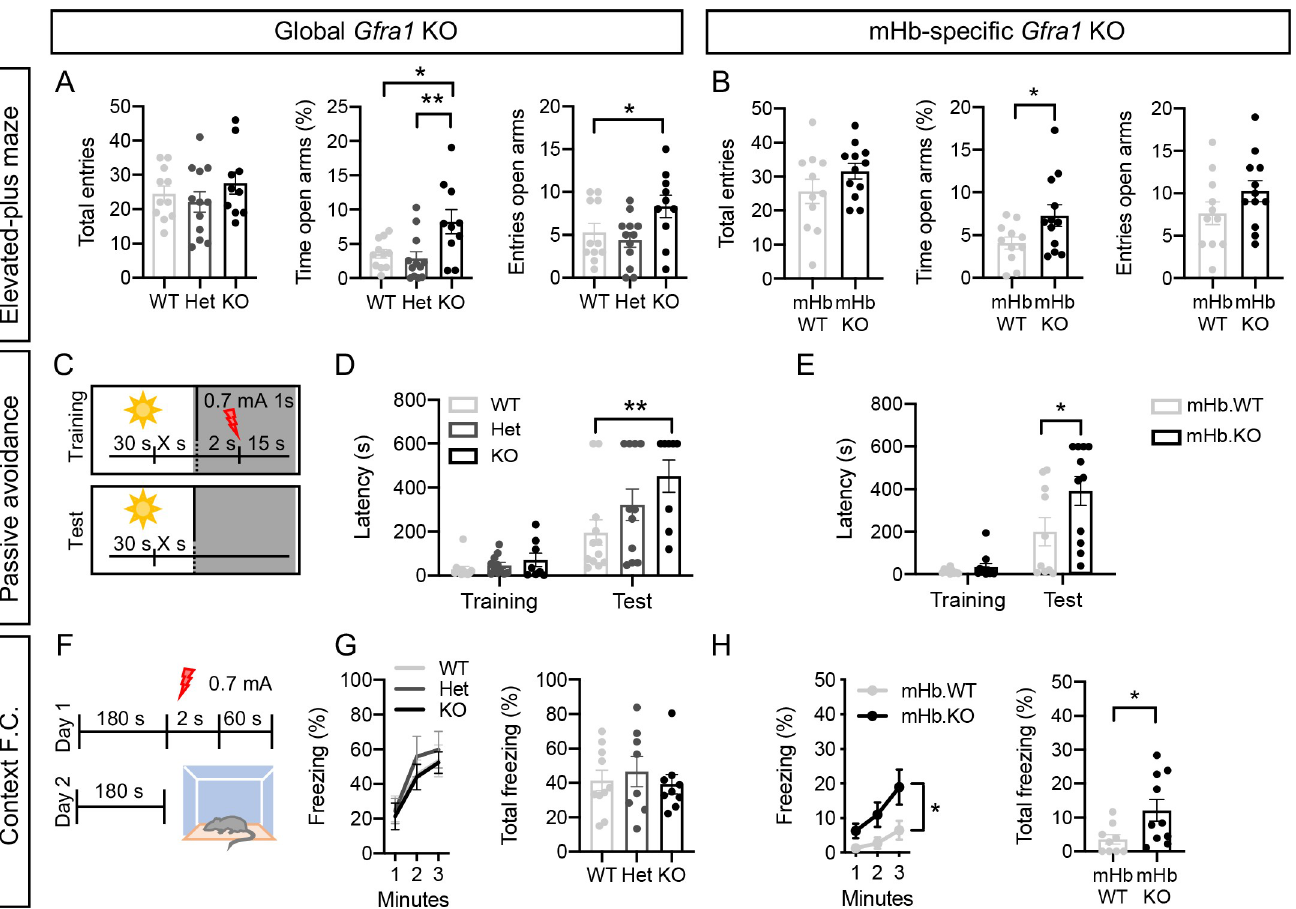
Fig 6. Acute loss of GFR α 1 in adult mHb neurons reduces anxiety-like behavior and potentiates context-based fear responses. (A, B) Total entries, time spent in open arms and open arms entries ( ± SEM) for WT, Het, and KO mice (A) and mHb.WT and mHb.KO mice (B) in the elevated plus maze test. N = 10–12 mice per group; 1-way ANOVA followed by Bonferroni post hoc test (A) and Student t test (B); � P < 0.05; �� P < 0.01. (C–E) Schematic (C) and latencies ( ± SEM) during training and test for WT, Het, and KO mice (D) and mHb.WT and mHb.KO mice (E) in the passive avoidance test. N = 8–12 mice per group; 2-way ANOVA followed by Bonferroni post hoc test; � P < 0.05; �� P < 0.01. (F–H) Schematic (F), freezing timecourse and total freezing time ( ± SEM) for WT, Het, and KO mice (G) and mHb.WT and mHb.KO mice (H) in the context fear conditioning test. N = 8–10 mice per group; 1-way ANOVA followed by Tukey post hoc test (G) and Student t test (H); � , P < 0.05; �� , P < 0.01. The data underlying this figure can be found at https://figshare.com/projects/Raw_Data_Fernandez-Suarez_et_al_2021/ 123406. HET, heterozygous; KO, knockout; mHb, medial habenula; WT, wild-type.